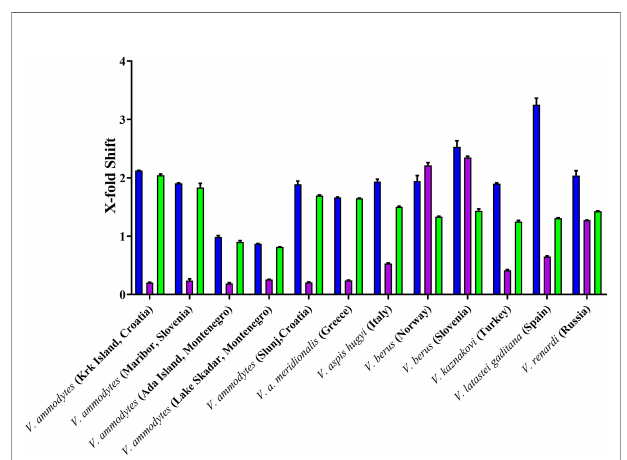
FIGURE 5 | X-fold magnitude of shift of plasma clotting time due to incubation of antivenoms indicated by: Inoserp in blue bars, ViperaTAb in purple bars; and VIPERFAV in green bars. X-fold magnitude of shift was calculated by the formula [(AUC of antivenom + venom/AUC of venom) -1]. A value of 0 indicates no shift (no neutralization by antivenom), while a value above 0 indicates neutralization by antivenom. Values are mean ± SD of N =